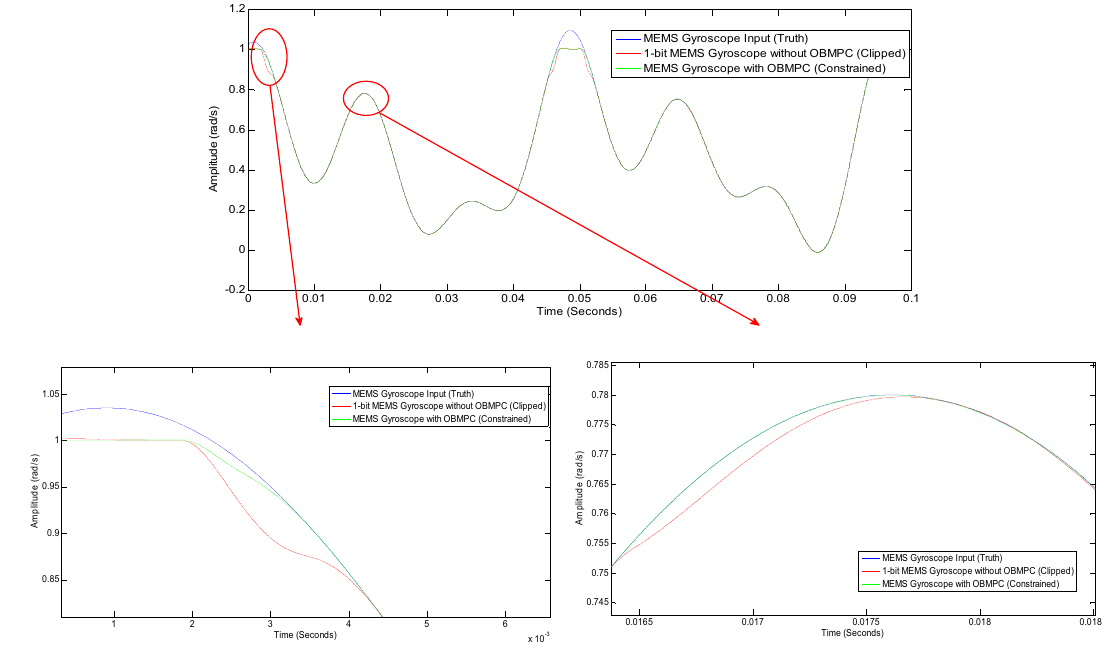
Figure 15. Comparisons between the OBMPC gyroscope and the conventional Δ∑ modulator-based gyroscope.